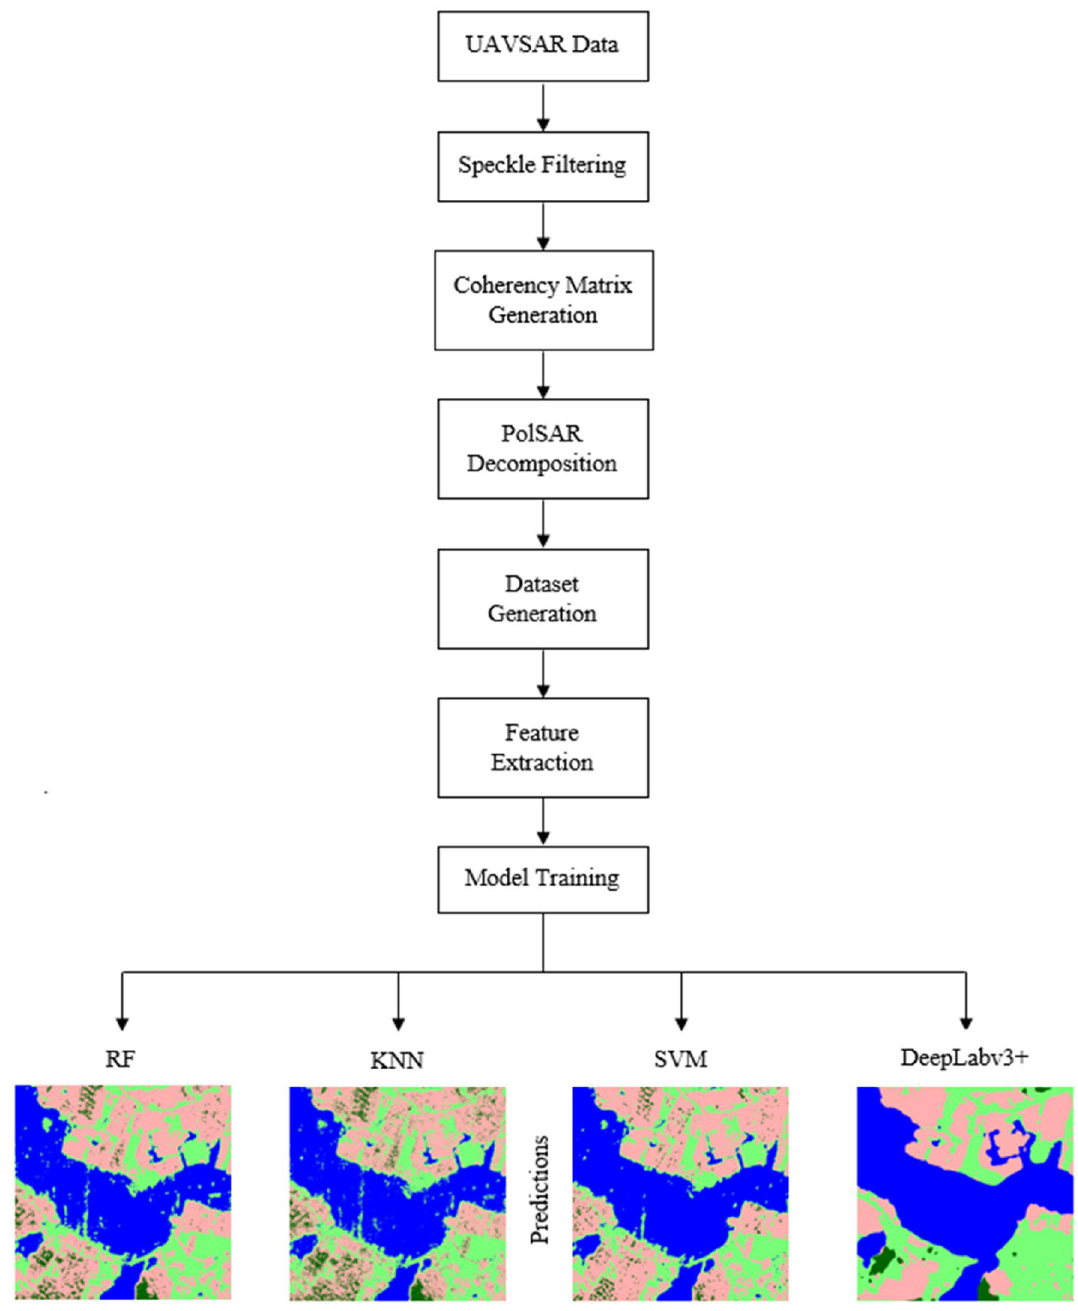
Figure 5. Represents the work flow of the methodology adopted for image segmentation using traditional machine learning algorithms and DeepLabv3+